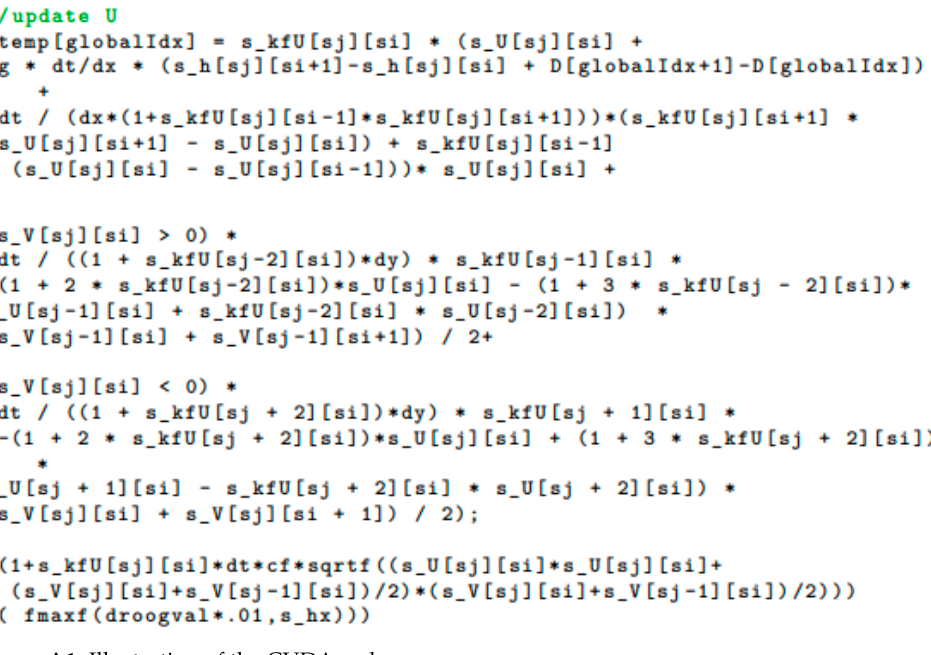
Figure A1. Illustration of the CUDA code.